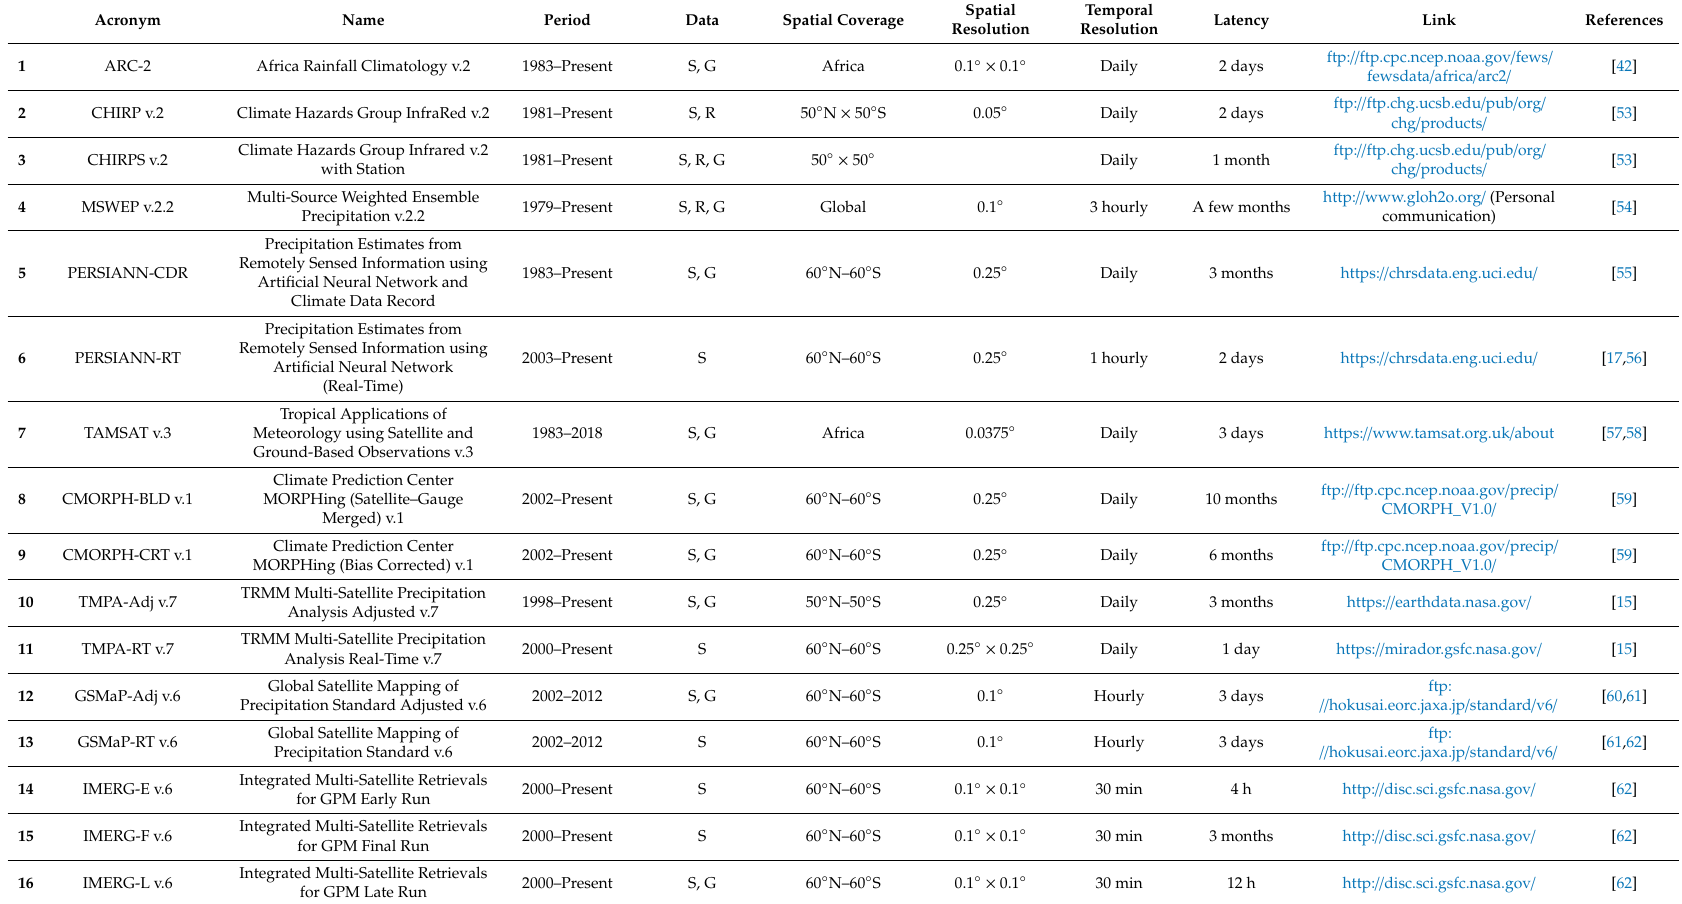
Table 1. Summary of main characteristics and references of the SPPs. The acronym S, R, G in the data column description stands for satellite, reanalysis, and gauge information; spatial coverage refers to the absolute maximum and minimum latitude with precipitation information, latency refers to the time delay for data